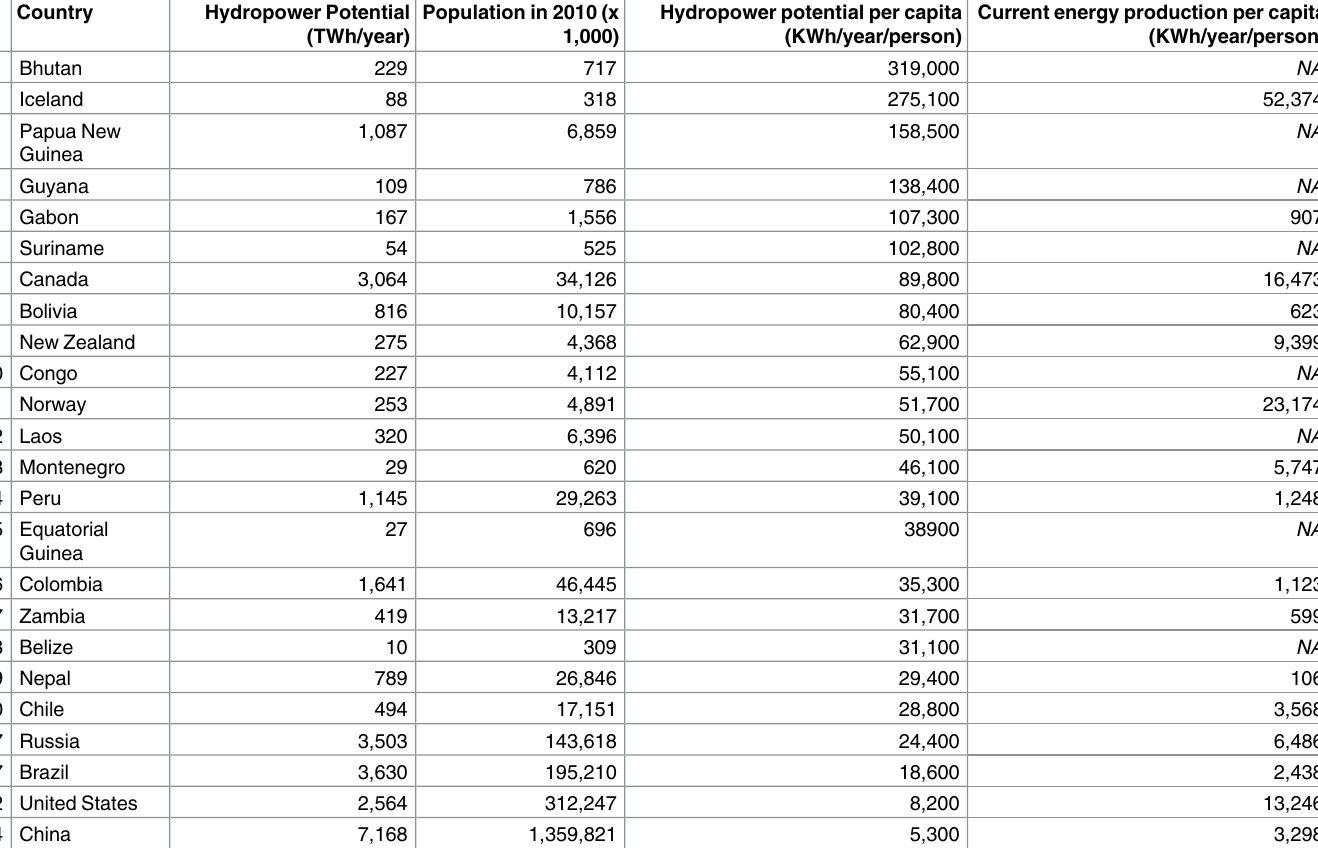
Table 1. Top 20 countries with the highest hydropower potential per capita.